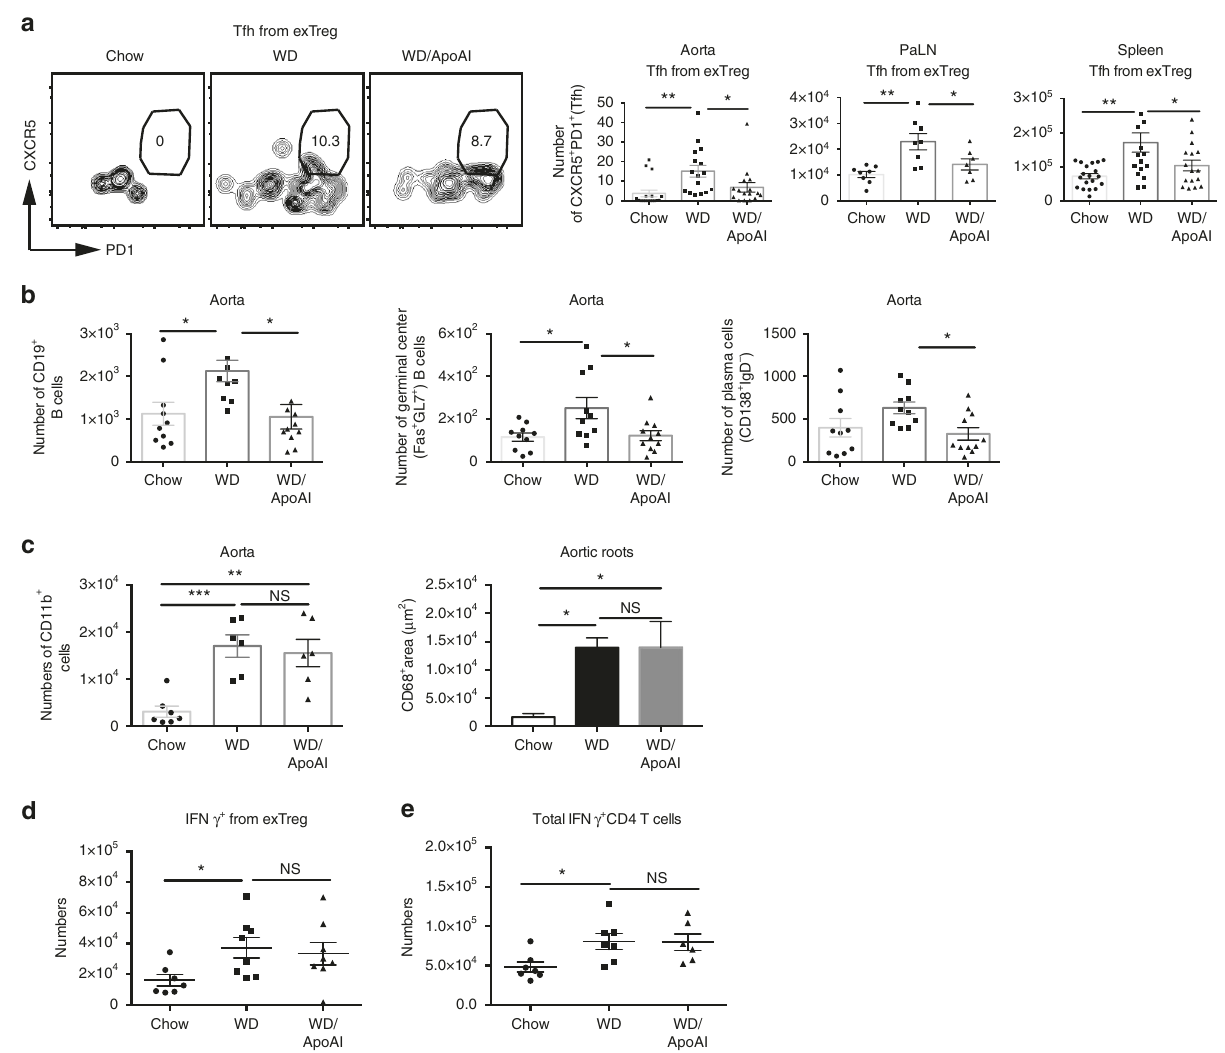
Fig. 7 ApoAI selectively prevents the conversion of exTreg into Tfh cells and reduces B cells in the aorta during atherogenesis. a Flow cytometry plots and graphs showing percentages and numbers of Tfh cells (CD44 hi CD62L lo CXCR5 + PD1 + ) from exTreg (CD4 + RFP + YFP − ) in the aorta, PaLN and spleen in LT- ApoE − / − western diet-fed mice with and without ApoAI treatment or chow controls. b Graphs showing numbers of B cells (CD19 + ), germinal center B cells (CD19 + Fas + GL7 + ) and plasma cells (CD19 + CD138 + IgD − ) in the aorta of the mice above. c Graphs showing numbers of CD11b + cells in the aorta by fl ow cytometry and area of CD68 + in aortic roots by immuno fl uorescence of the mice above. d , e Graphs showing numbers of IFN γ + from exTreg, and IFN γ + from total CD4 T cells ( d, e , respectively) in the PaLN of the above mice, following stimulation with PMA/ionomycin for 5 h. Results are expressed as mean ± s.e.m from three independent experiments ( n = 19 (Chow), n = 16 (WD and WD/ApoAI)) ( a ), mean ± s.e.m from two independent experiments ( n = 10) (b), mean ± s.e.m from one experiment ( n = 6 (Chow and WD), n = 7 (WD/ApoAI)) ( c ) and n = 7 ( d – e ). Statistical signi fi cant differences were at * P < 0.05, ** P < 0.01, and *** P < 0.001 (one-way